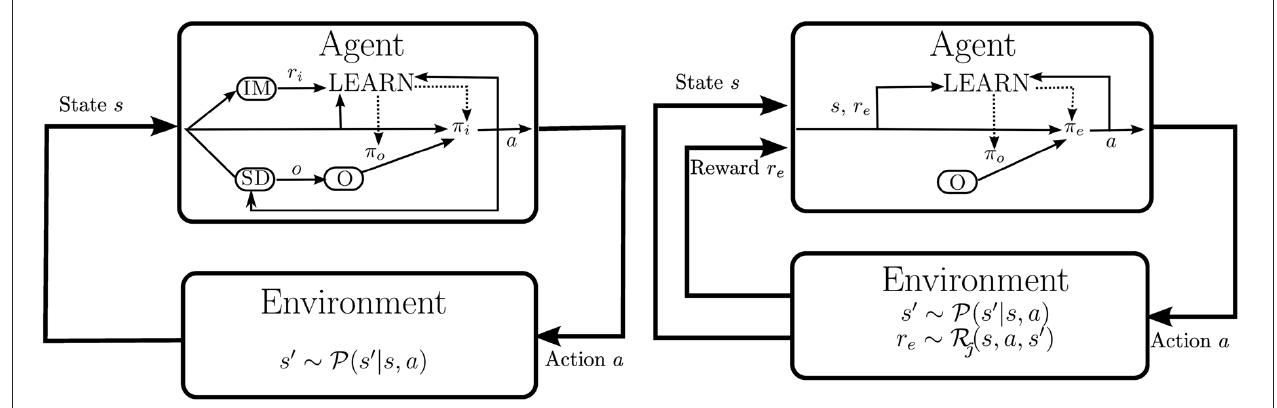
FIGURE 2 | Left plot: Agent architecture employed during the developmental period. No external reward is provided but the motivational system IM creates an intrinsic reward r i . In parallel, new skills o are identified using the skill discovery module SD and added to the skill pool O . The policy π i selects skills